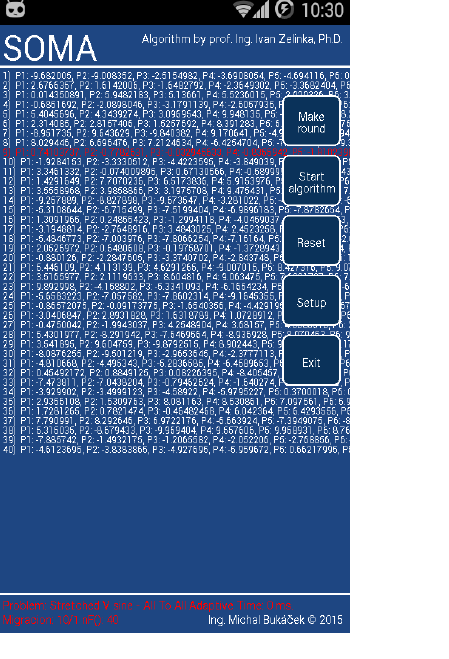
Fig. 4: Select problem function Source: Custom pro- cessing (cid:21) app screenshot